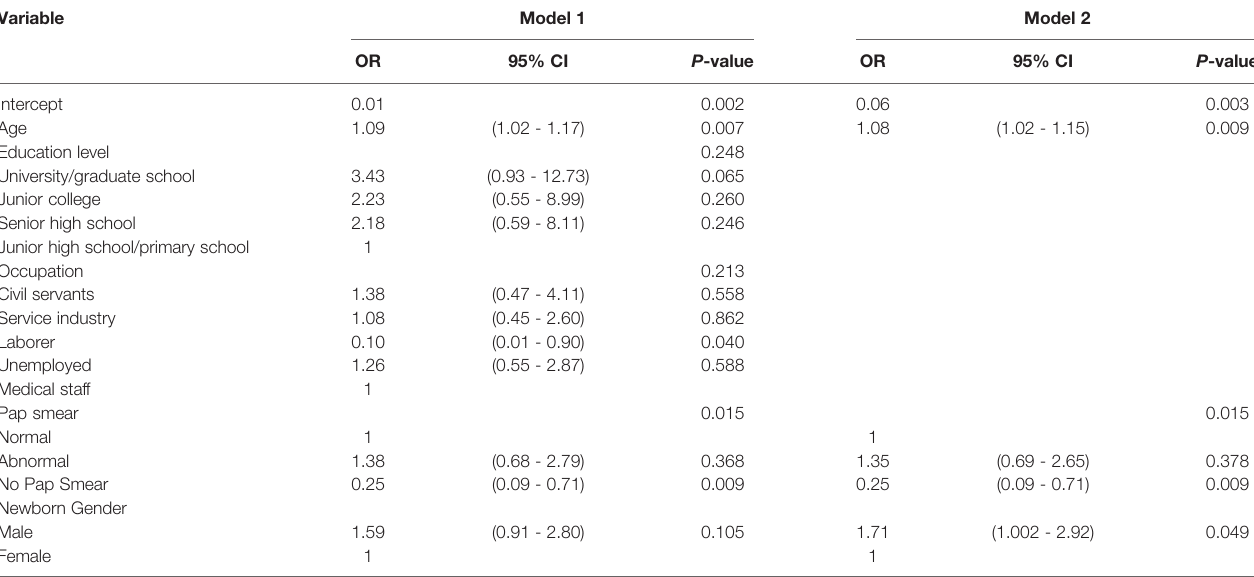
TABLE 2 | The effect factors of vaccination willingness in the multiple logistic regression analysis.